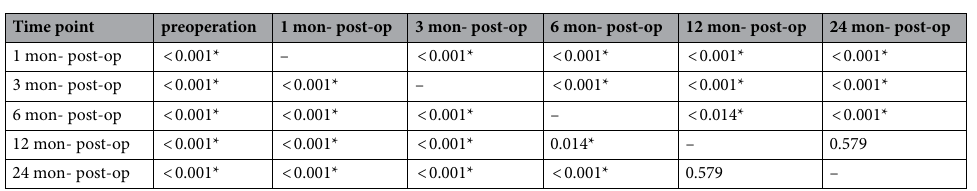
Table 3. The P values of VAS score between every two time points by LSD. VAS visual analogue scale, mon‑ month or months, post‑op postoperation. *Difference was statistically significant; “–” The same time point;